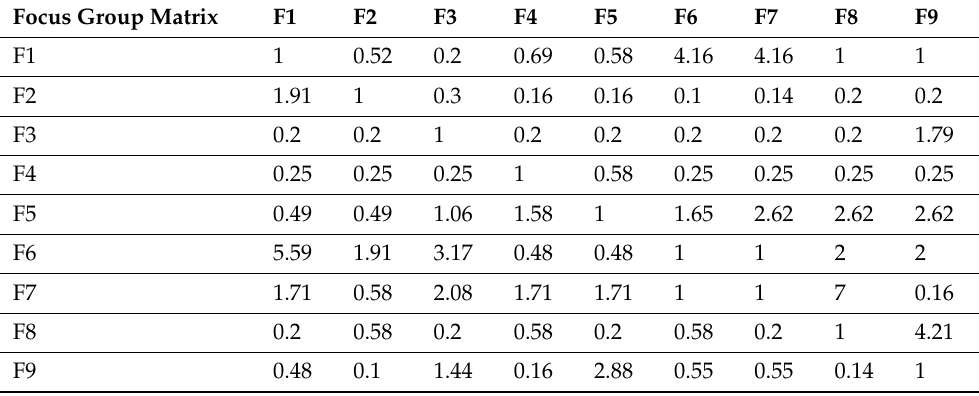
Table 6. AHP Geometric Mean Pairwise Comparison Matrix.